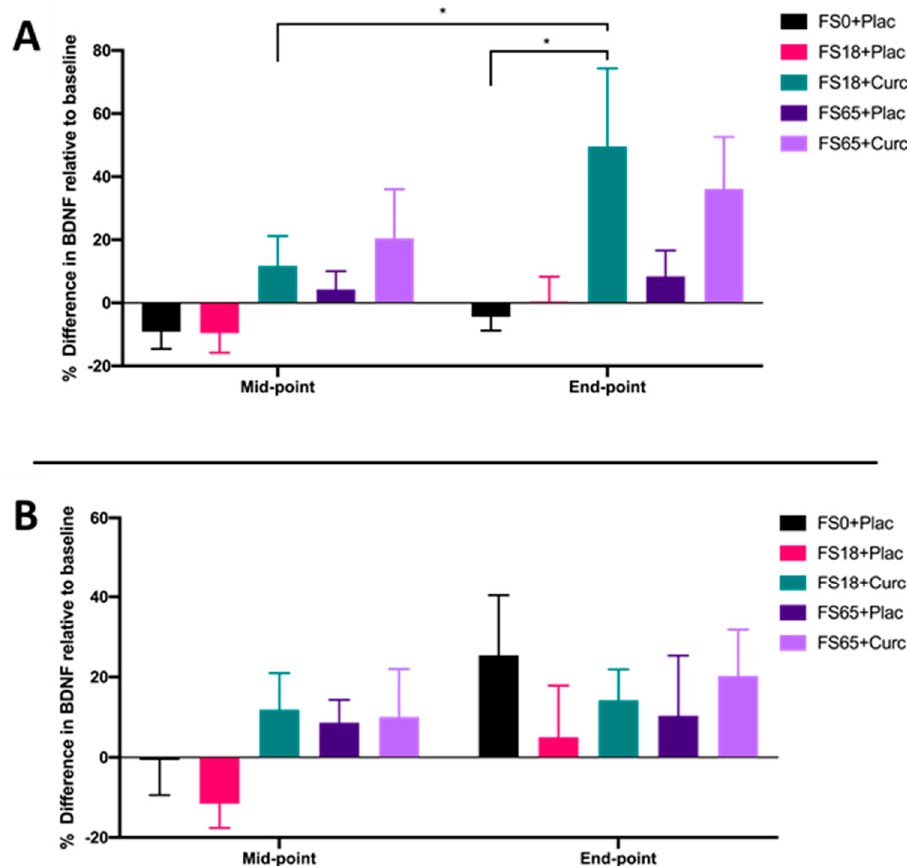
Figure 3. ( A ). Mean ± SEM, % di ff erence in BDNF for participants with low ferritin at Figure 3. (A). Mean ± SEM, % difference in BDNF for participants with low ferritin at baseline (< 50